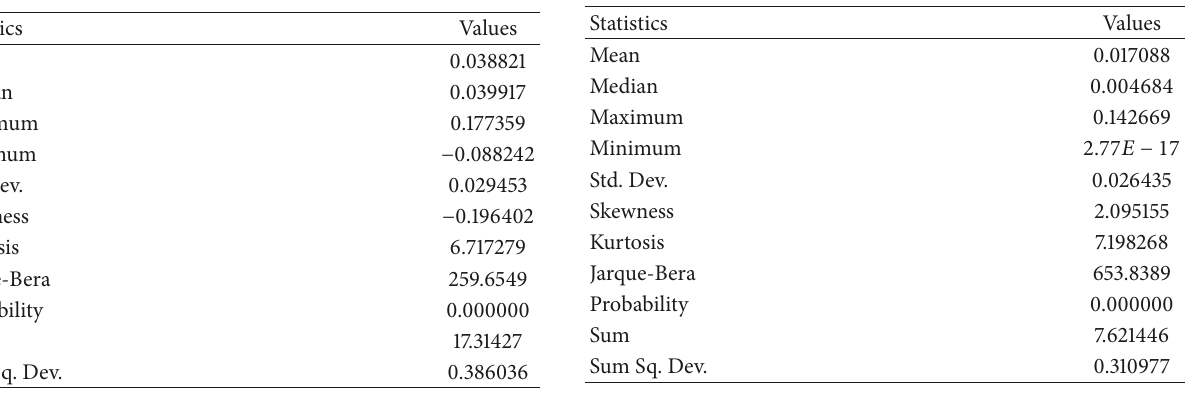
Table 3: Asymmetry perception evolution statistics in 2012-2013.